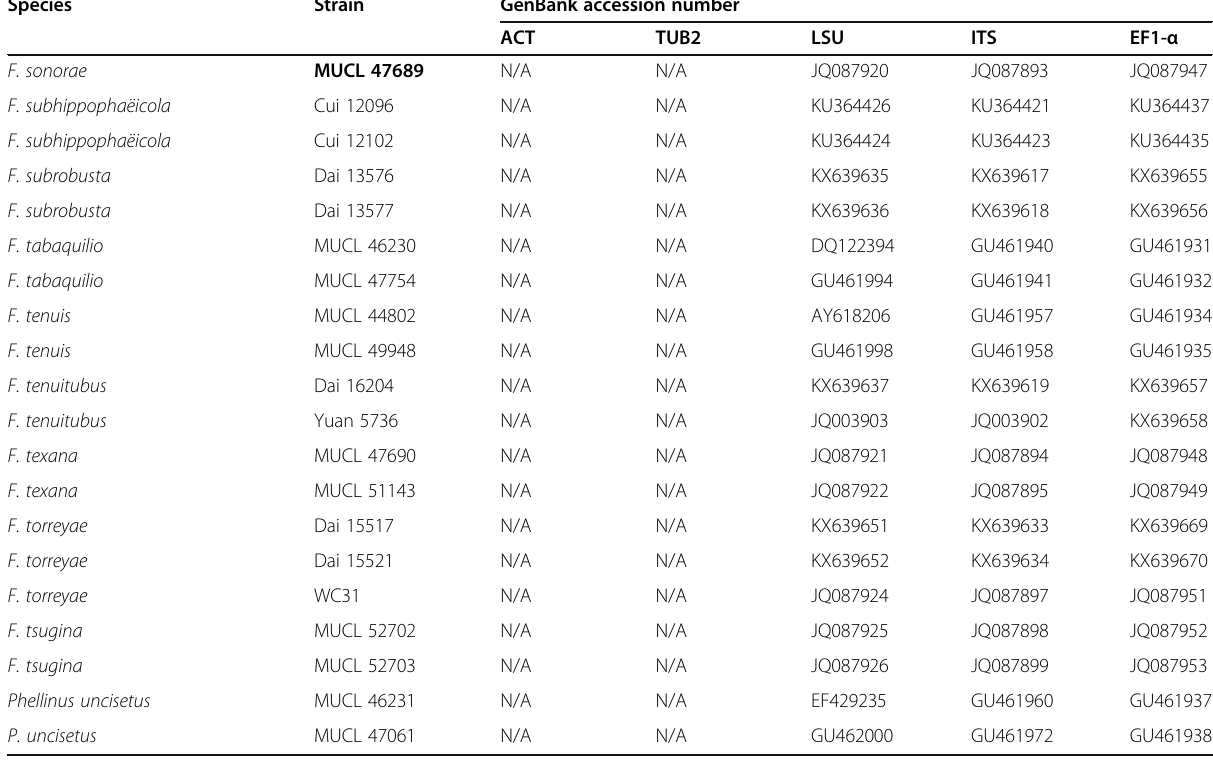
Table 2 Isolates and GenBank accession numbers of Phaeoacremonium and Fomitiporia species in this study (Continued)